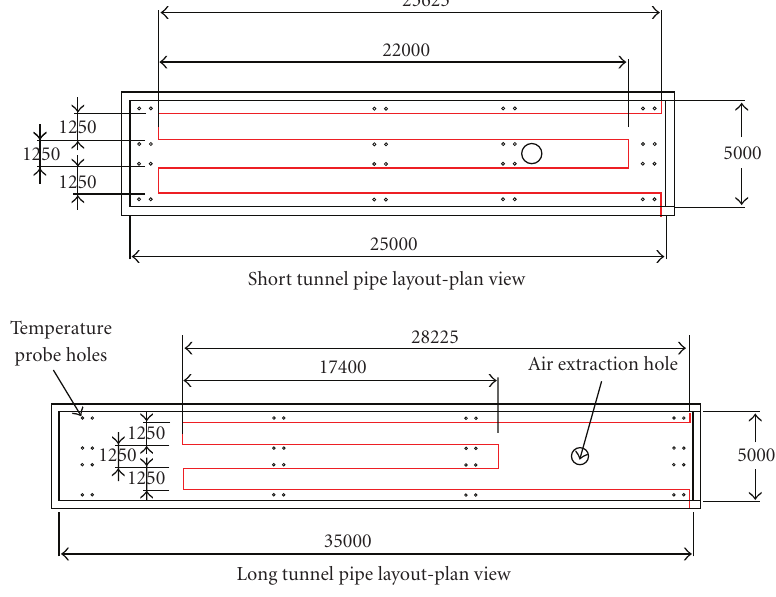
Figure 6: Suggested pipe layout for short and long in-vessel units. Table 8: Costs benefit